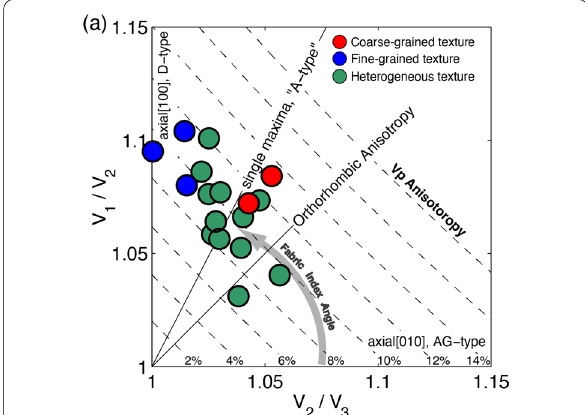
Fig. 7 V P ‑Flinn diagram for the 139°E Ridge peridotites. Red symbols indicate coarse‑grained texture, blue symbols indicate fine‑grained texture, and green symbols indicate samples with heterogeneous